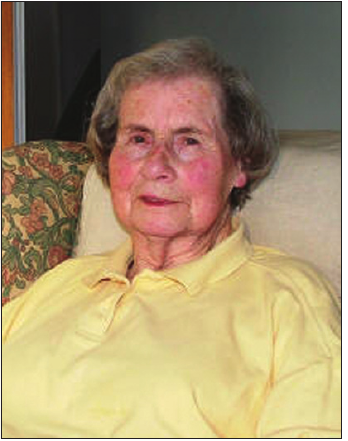
Figure 5: Cecilia Western (Photo Eleni